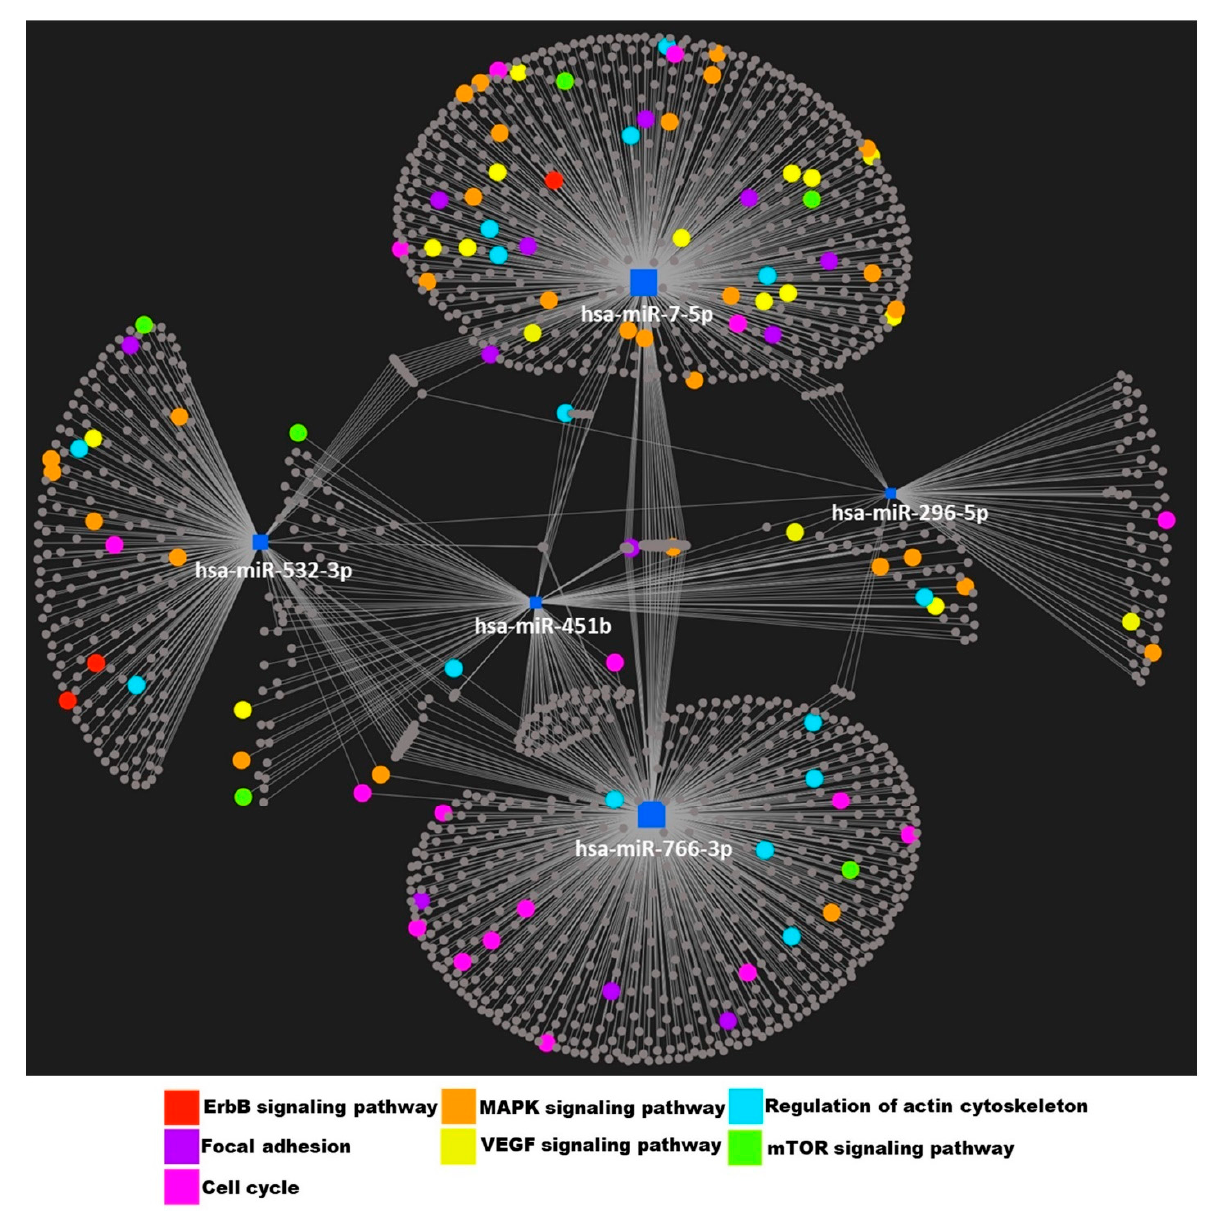
Figure 3. Network between 5 replicated miRs and gene targets. Nodes with different colors indicate genes in selected enriched KEGG pathways.